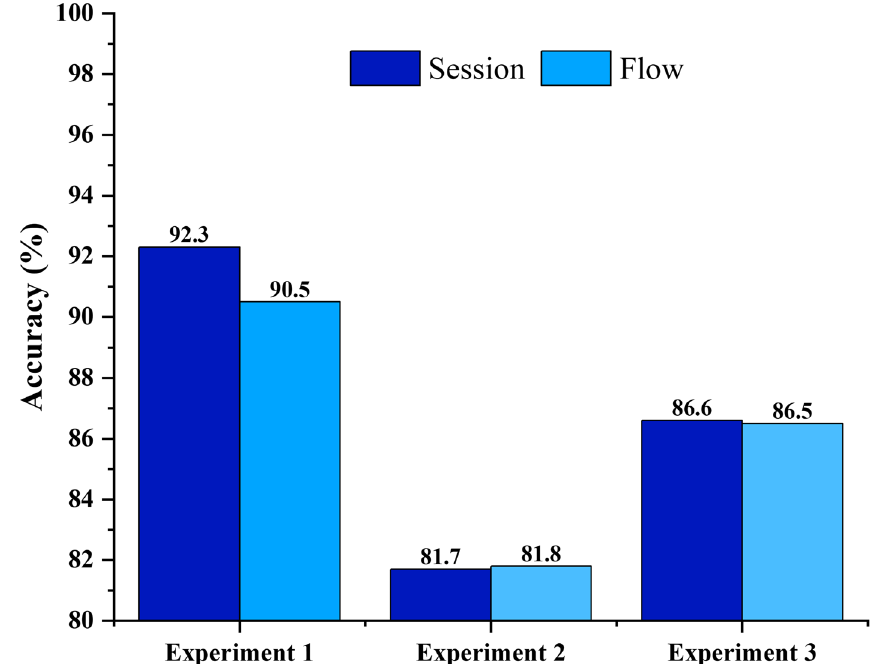
Fig. 9 Accuracy of three experimental sessions with